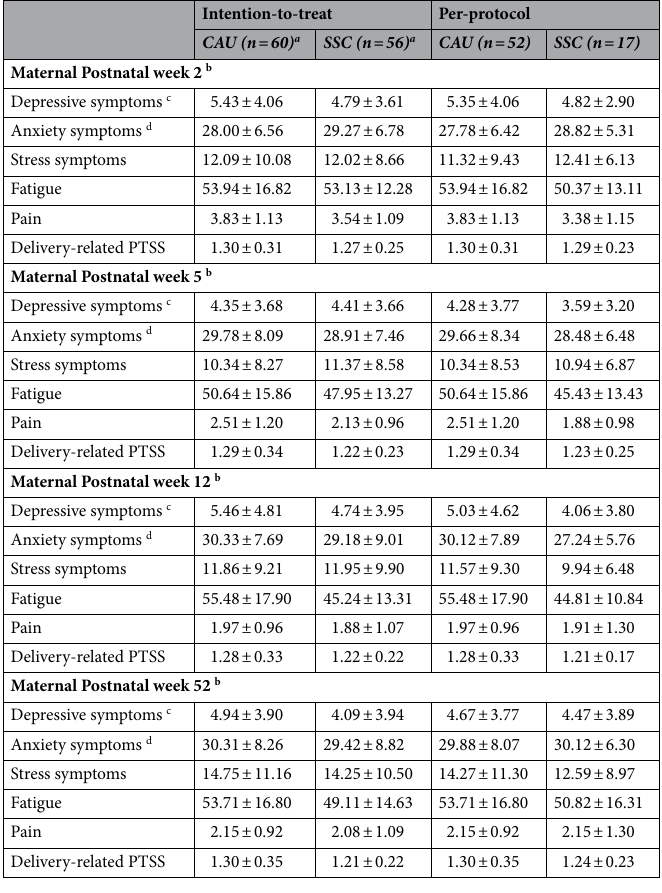
Table 2. Outcome measures of randomized participants. CAU care-as-usual, PTSS post-traumatic stress symptoms, SSC skin-to-skin contact. a Numbers represent the total group. For fatigue, pain, and delivery- related PTSS, 52 mothers are included in the SSC group and 57 mothers in de CAU group due to the exclusion of 7 mothers who gave birth via cesarean. b Winsorized data is presented for all moderator variables that included outliers. c A threshold of 10 indicates clinical levels of depression. d A threshold of 40 indicates clinical levels of